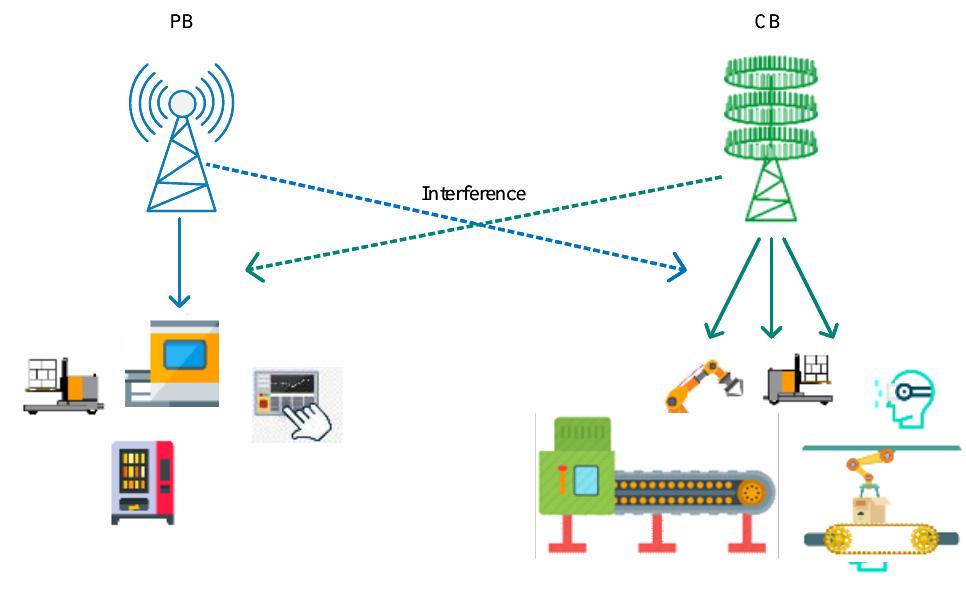
Figure 1. System